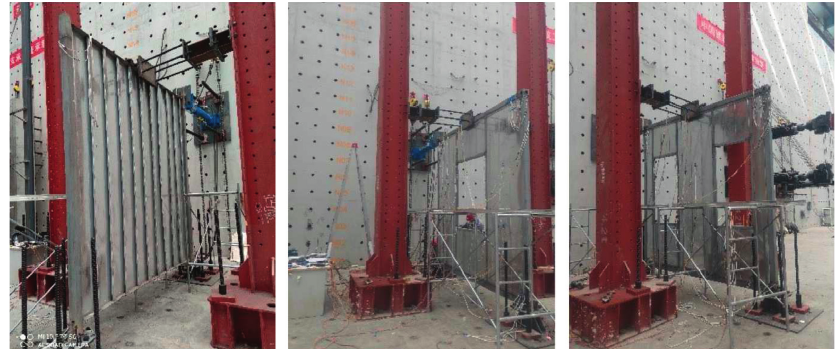
Figure 1: Experimental photos.